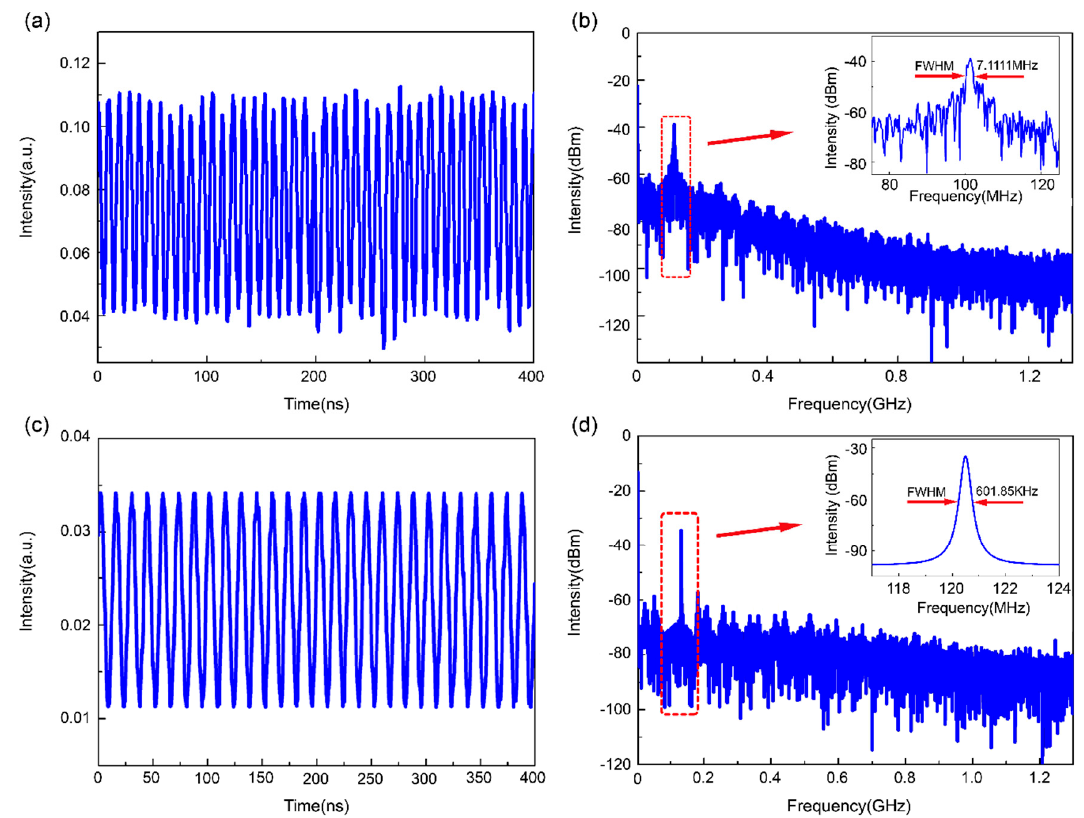
Figure 4. ( a ) Time domain beat signal measured by an oscilloscope with the free-running DFB laser. ( b ) The beating spectrum in the free-running case. Inset: zoom-into around the peak showing the beat frequency of 7.1 MHz. ( c ) Time domain beat signal measured with the injection-locking. ( d ) Beat spectrum in the self-injection locked case. Inset: zoom-into around the beating frequency.